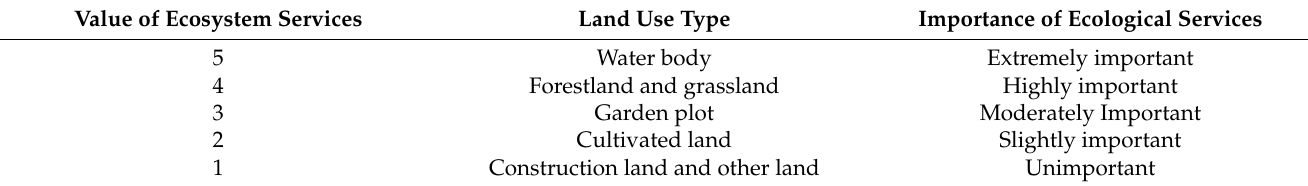
Table 1. Ecosystem service value of land use types.